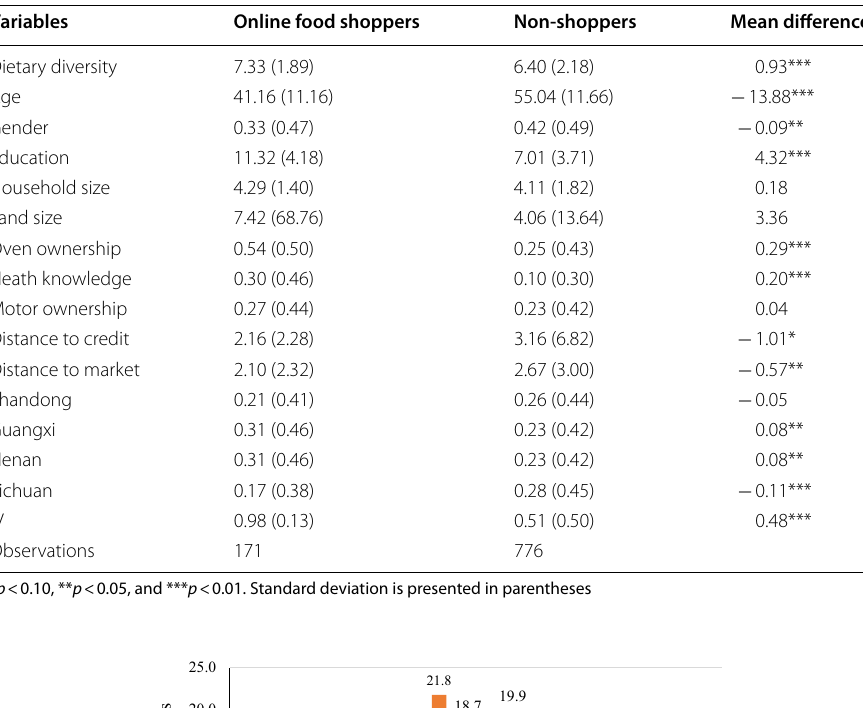
Table 3 Mean differences of the variables between online food shoppers and non-shoppers